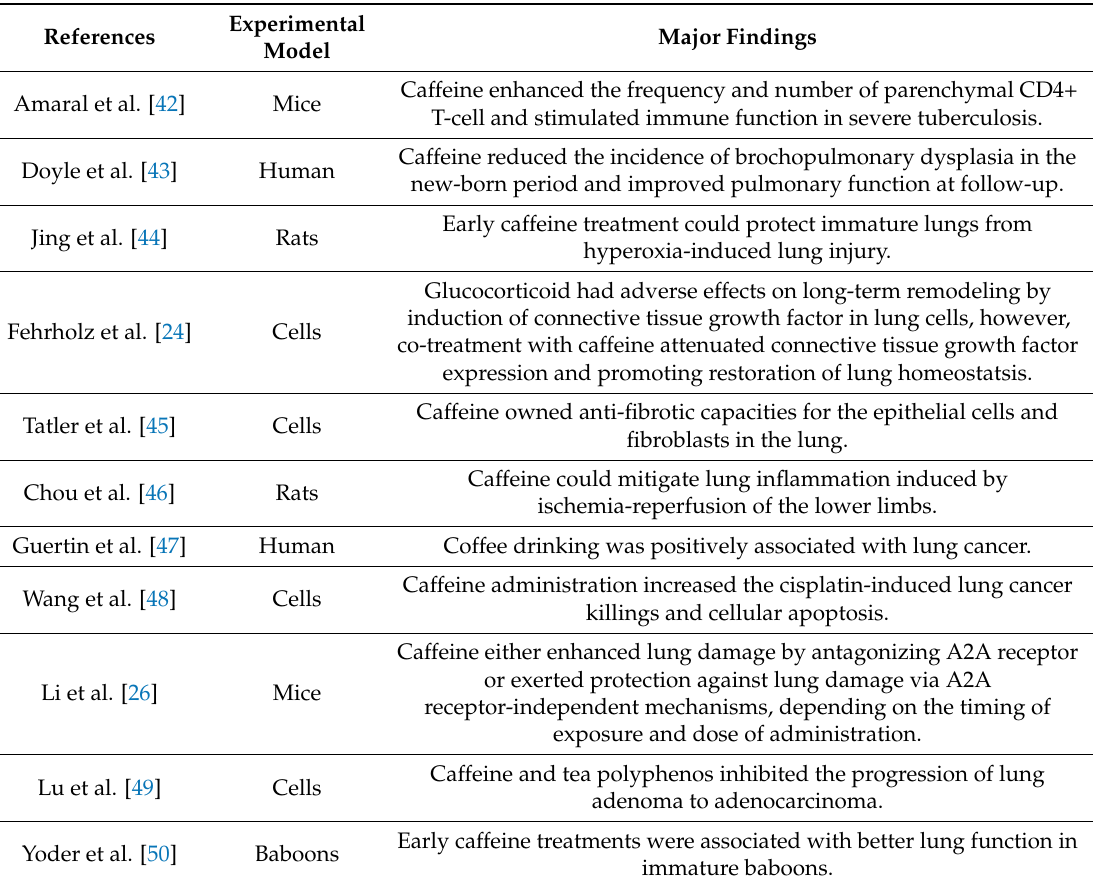
Figure 4. The postulated mechanisms regarding the effect of caffeine on the lung.